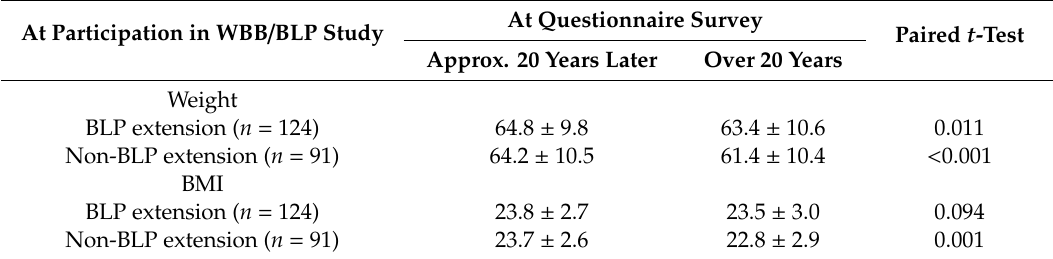
Table 3. Changes in weight and BMI over 20